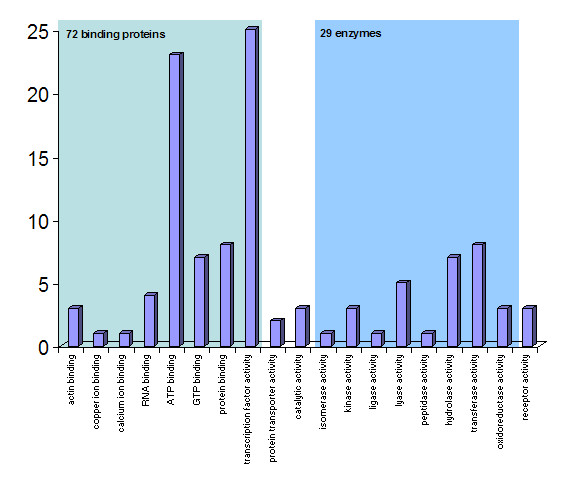
Abundances of gene functions (according to GO) of all fish protein genes under positive Darwinian selection with significantly lower or higher distance to the human ortholog than to other fish species.